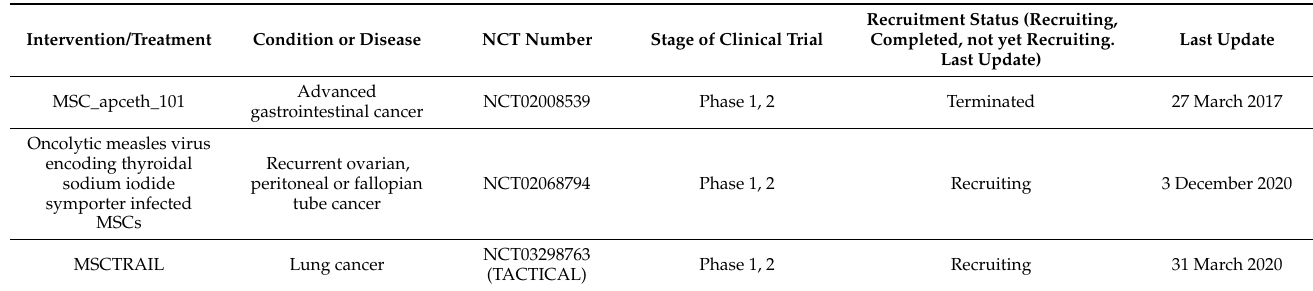
Table 3. Overview of clinical trials with transplantation of mesenchymal stem